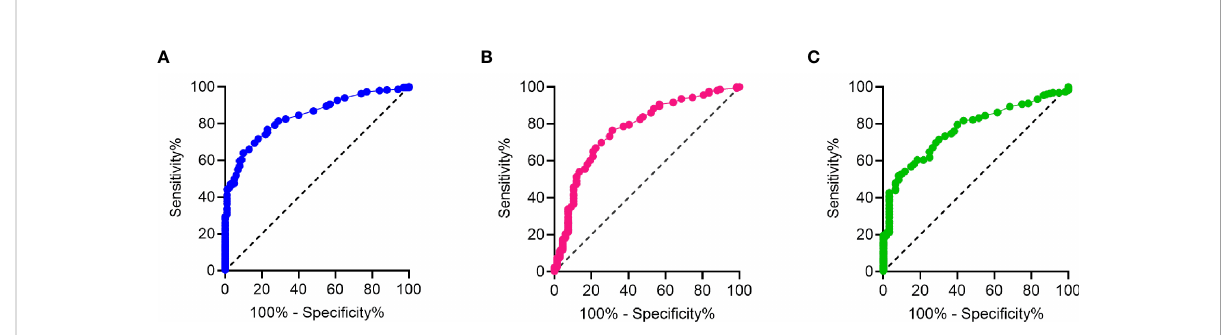
FIGURE 5 ROC analysis of CCl21 levels from ELISA 1, Luminex and ELISA 2. (A) ROC analysis of CCL21 levels from ELISA 1 with AUC=0.843, 95% CI = 0.084-0.883 and p<0.001, (B) ROC analysis of CCL21 levels from Luminex with AUC=0.772, 95% CI = 0.711-0.833 and p<0.001, and (C) ROC